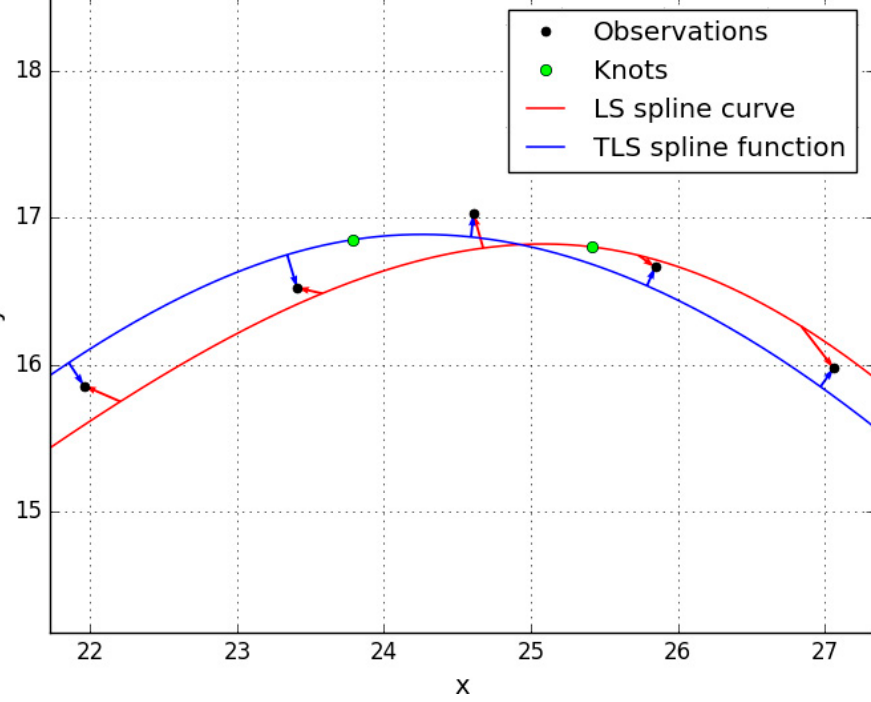
Figure 6. Magnification of the area marked by a rectangle in Figure 5.